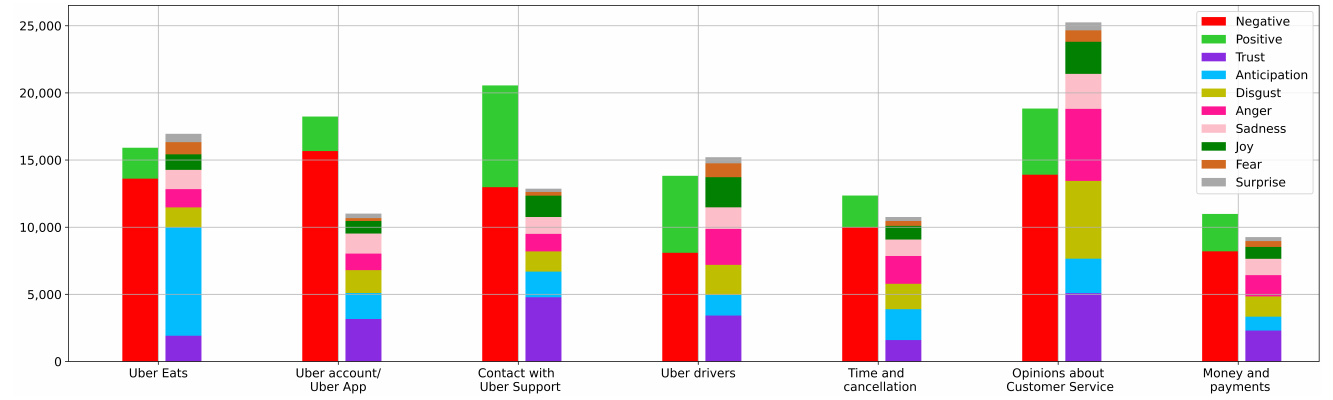
Figure 9. Sentiments and emotions associated with each